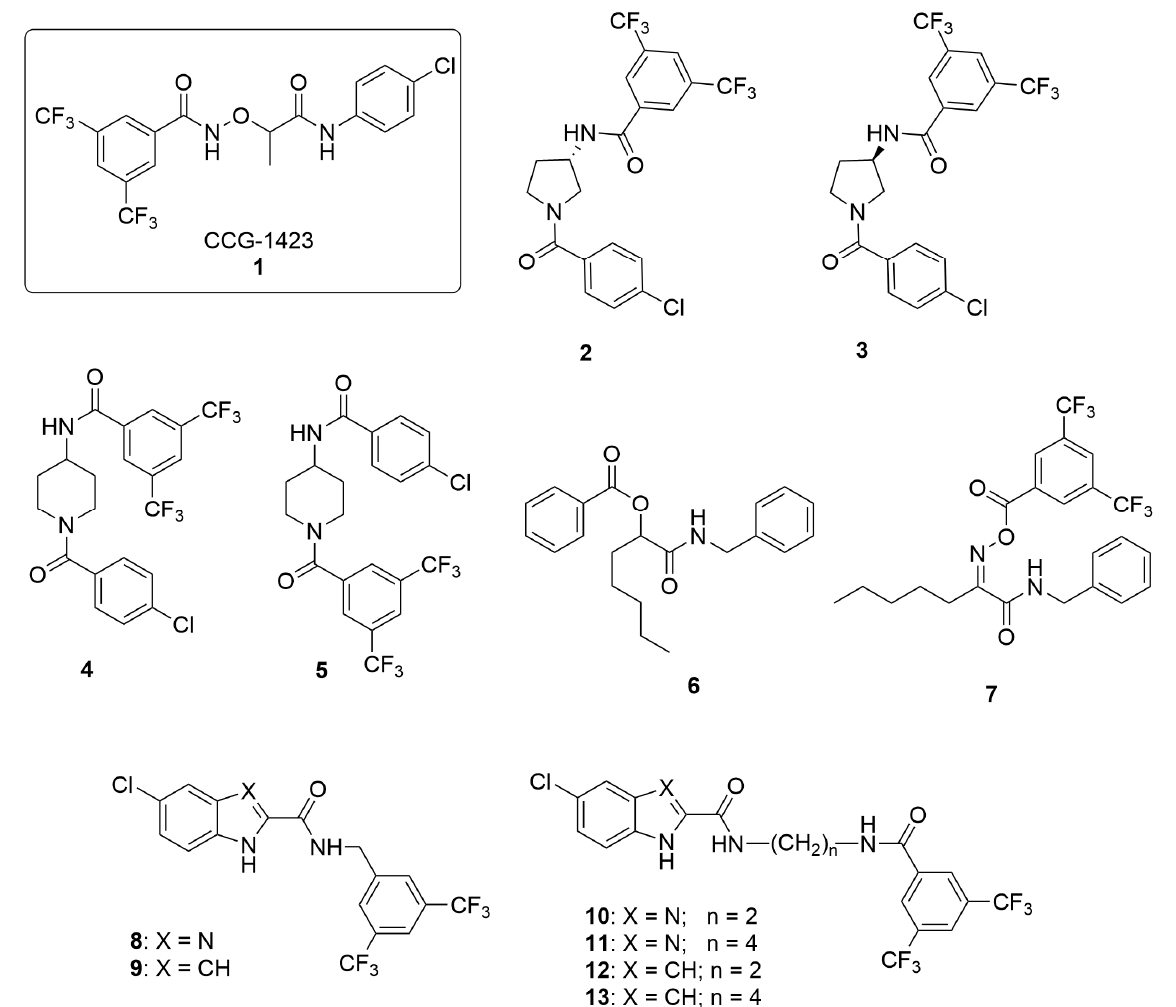
Figure 1. Chemical Structure of CCG-1423 and molecules herein